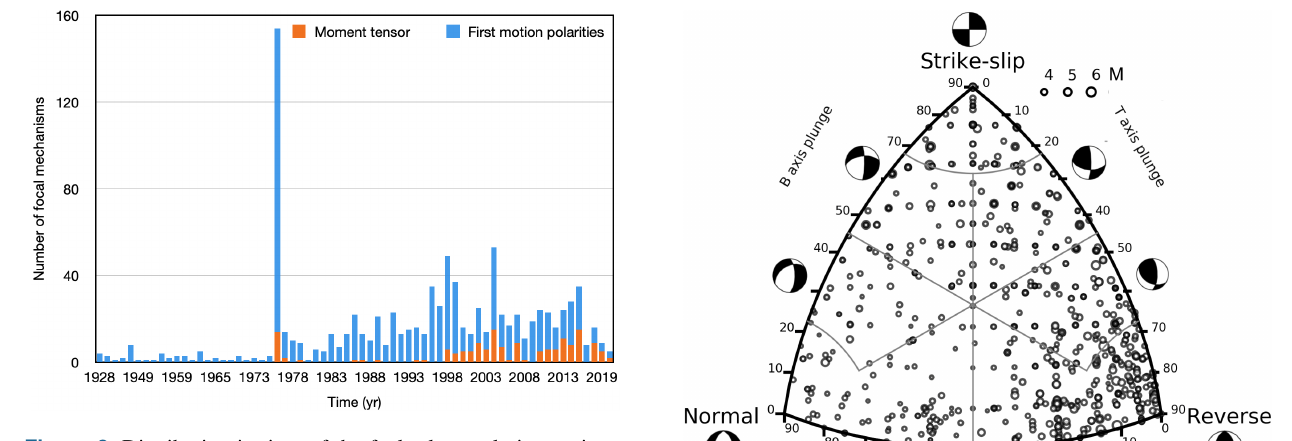
Figure 3. Distribution in time of the fault plane solutions using a 1-year bin (year vs. number of fault plane solutions).